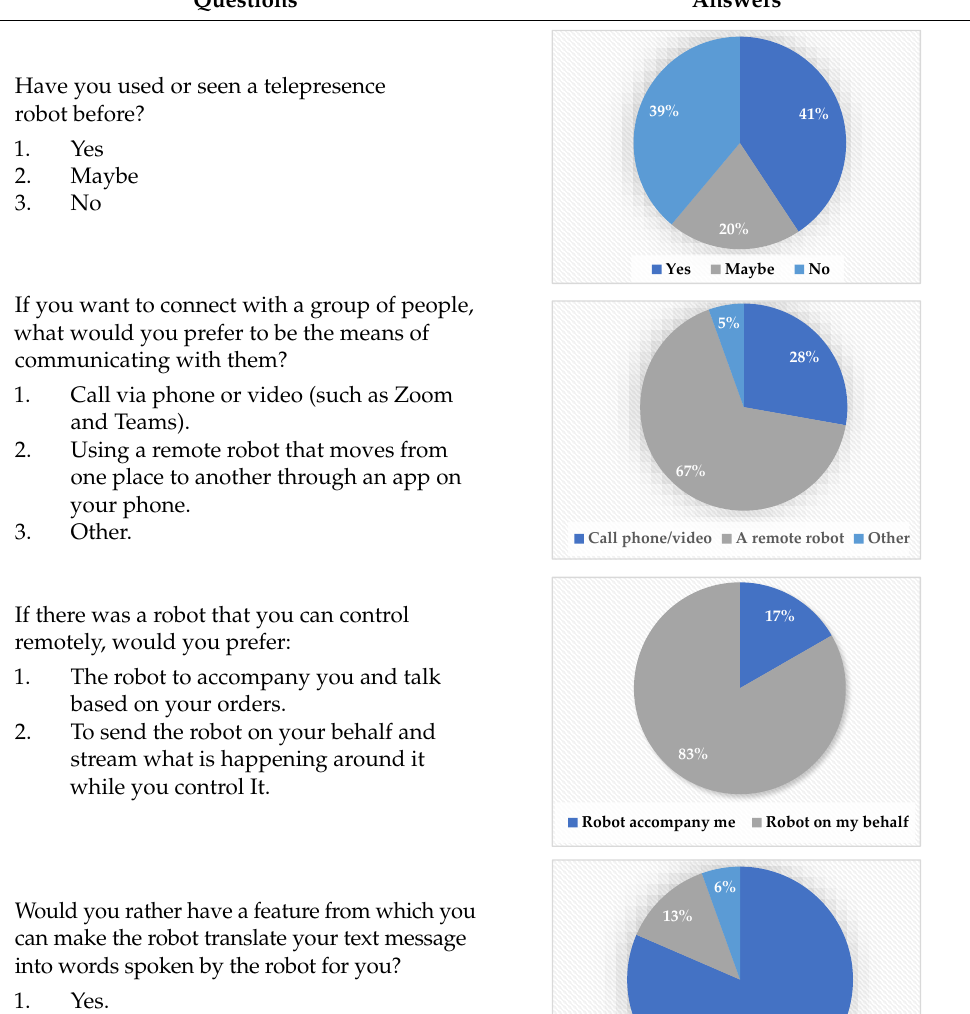
Table 2. Elicitation study questionnaire.